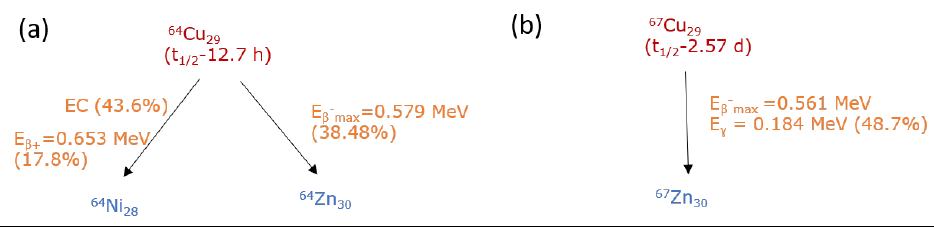
Figure 3. Decay scheme of ( a ) Copper-64 ( b )